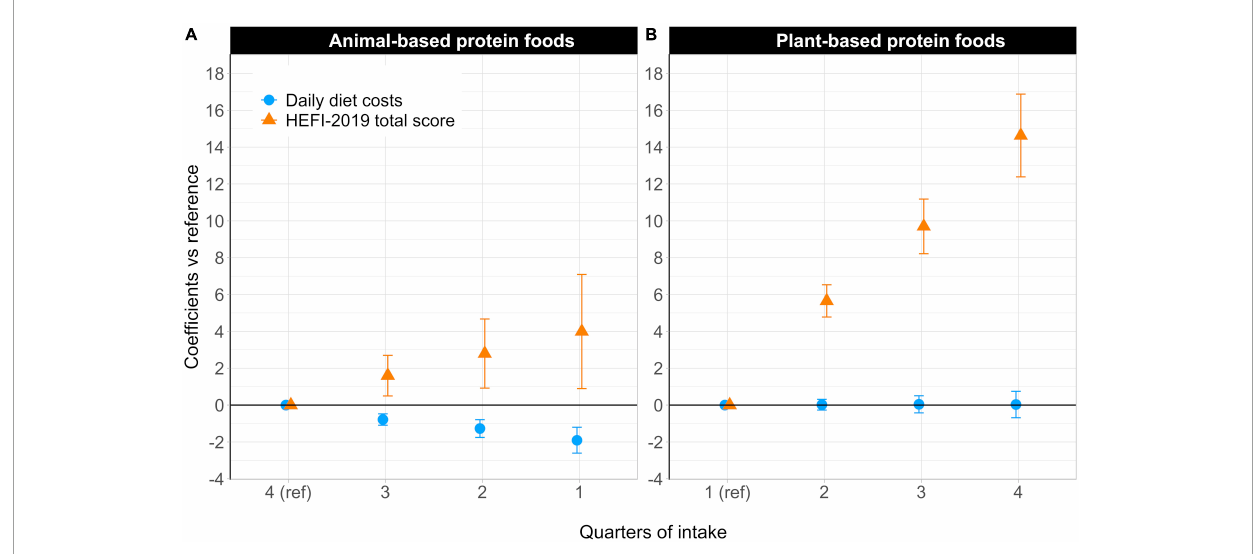
FIGURE1 (A) Differences in the HEFI-2019 total score and daily diet costs across quarters of animal-based protein food intake. The HEFI-2019 total score and daily diet costs for the reference quarter (Q4) of animal-based protein food intake were 41.7 pts (SE, 0.8) and 13.7 $CAD per 2,500 kcal (SE, 0.2), respectively. (B) Differences in the HEFI-2019 total score and daily diet costs across quarters of plant-based protein food intake. The HEFI-2019 total score and daily diet costs for the reference quarter (Q1) of plant-based protein food intake were 36.3 pts (SE, 0.6) and 12.7 $CAD per 2,500 kcal (SE, 0.2), respectively. The regression coefficients scaled on the y-axis in both panels represent the differences in the HEFI-2019 total score (points) and daily diet costs ($CAD/2500 kcal) compared to the quarter of reference. Dietary intake data and costs standardized to 2,500 kcal were modeled using the National Cancer Institute’s multivariate method to reflect usual intakes. SE and 95% CI were calculated using 200 bootstrap resamples. HEFI-2019, Healthy Eating Food Index-2019; Ref,